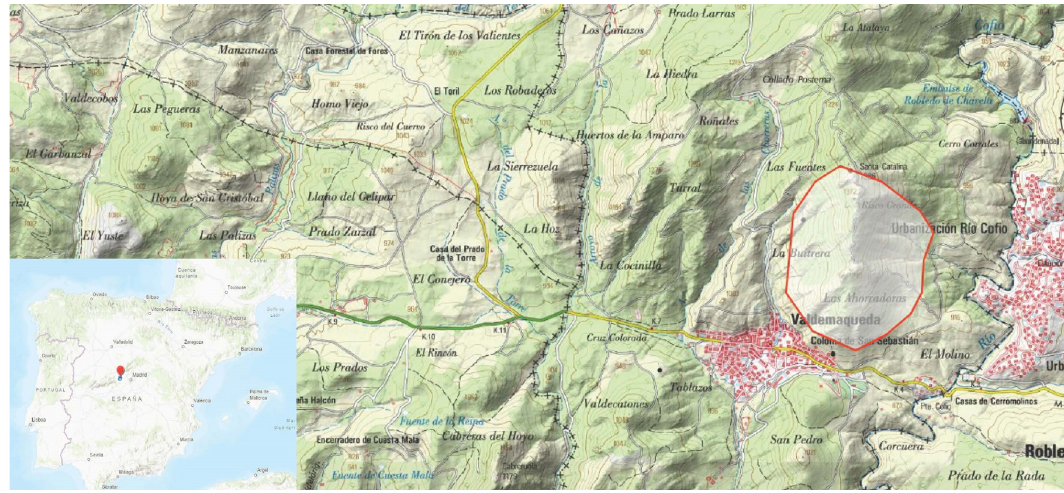
Figure 1. The geographical location of the Valdemaqueda municipality, within the Madrid Autonomous Community. The study area is circled in